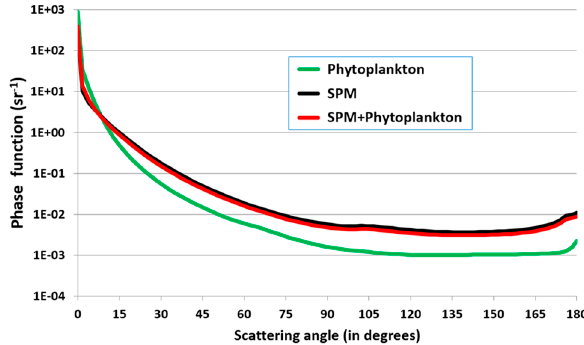
Figure 3. Phase functions of the hydrosols, namely phytoplankton, suspended particulate matter (SPM) and their mixture, modelled using Mie theory for the benchmark case of simulation (Table 1).